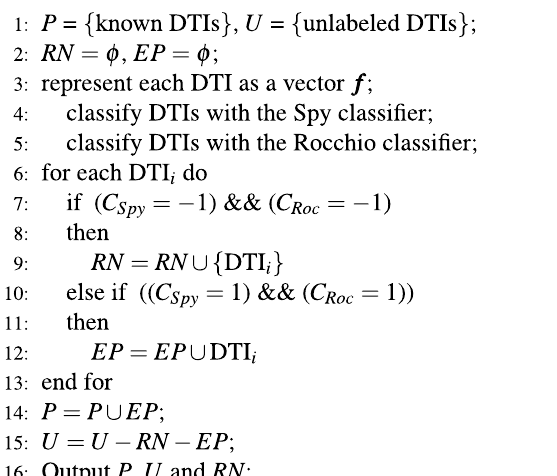
Algorithm 1. The NDTISE